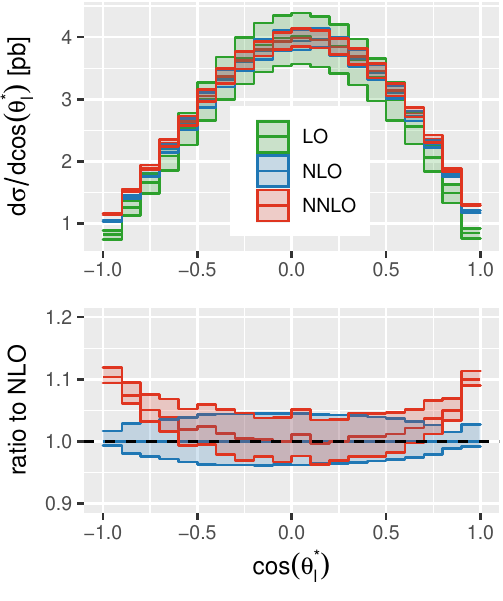
Figure 20 . Angular distribution for cos θ ∗